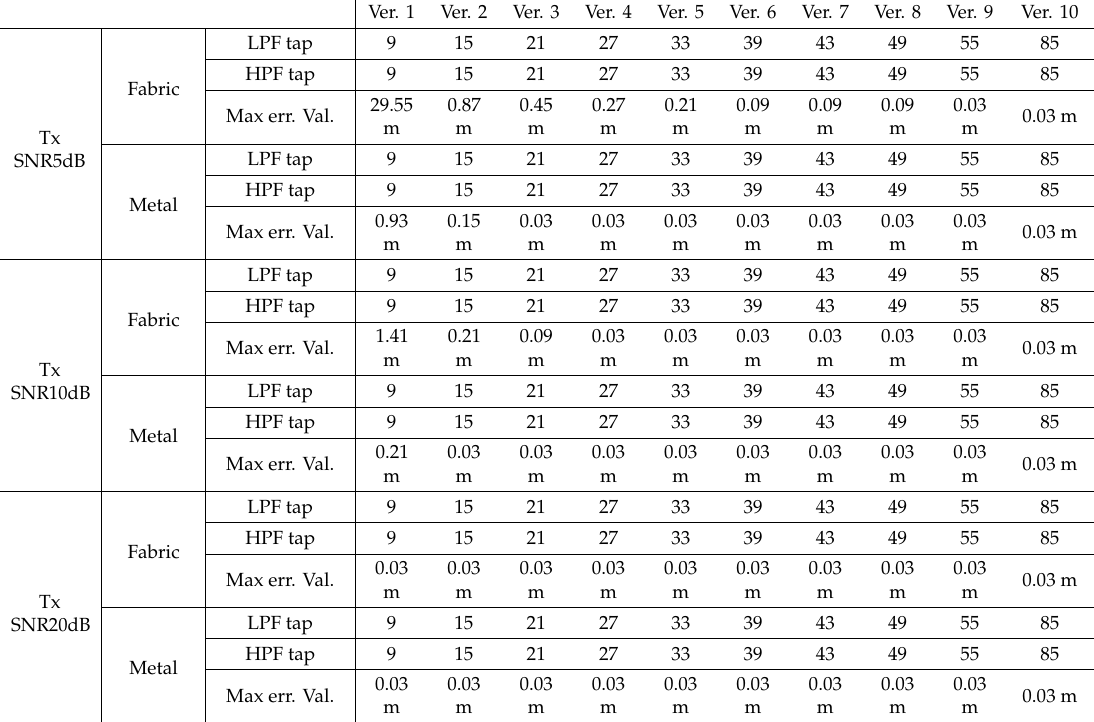
Table 3. Error output by transmission power, medium type, and Filter Tab number.